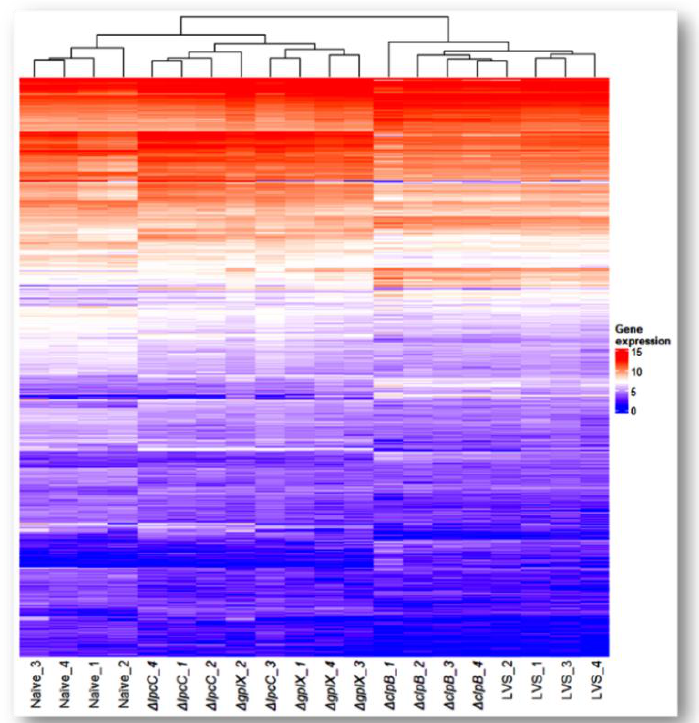
Figure 1. Transcriptome overview. Heatmap of expression profile of differentially expressed genes across four vaccine strains. Genes that changed their expression levels significantly ( p < 0.05) in at least one of the vaccinated samples when compared with the naïve sample were extracted from the data set. All four replicates of each sample group were included to show reproducibility. A total of 5361 genes were compiled. Data values were log 2